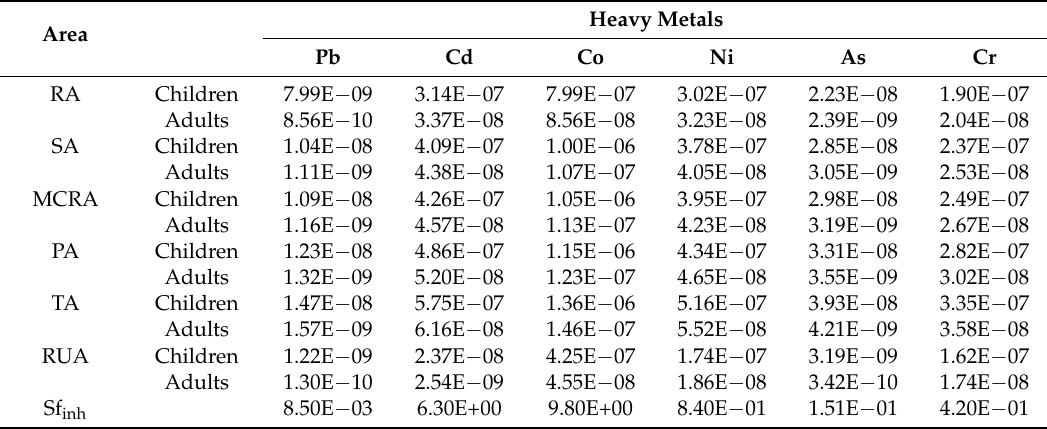
Table 9. Carcinogenic risk (CRA) of each heavy metal for children and adults population living in different functional areas.